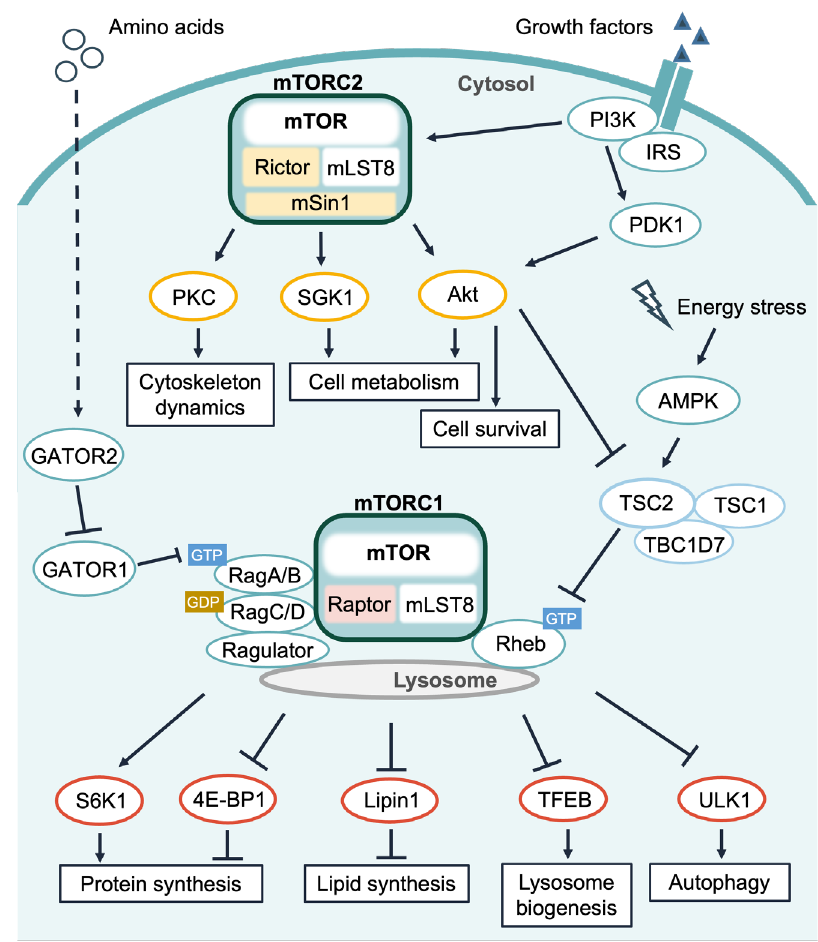
Figure 1. General functions of mTOR signaling. mTORC1 is primarily composed of mTOR, Raptor, and mLST8. mTORC2 is composed of mTOR, Rictor, mSin1, and mLST8. Multiple stimuli, including amino acids, growth factors, and energy stress regulate mTORC1 activity via the GATOR2–GATOR1–Rag GTPases axis and the TSC2–Rheb GTPase axis. mTORC1 mainly functions to activate anabolism, protein synthesis, or lipid synthesis and to inhibit catabolism, lysosome biogenesis, or autophagy by directly phosphorylating various substrates (closed red curves in oval shapes). In contrast, mTORC2 is thought to respond to growth factors or insulin. Activated mTORC2 regulates cell survival, metabolism, and cytoskeleton dynamics by directly phosphorylating the AGC kinase protein family of Akt, PKC, and SGK1. Major direct substrates of mTORC2 are shown by closed orange curves in oval shapes.